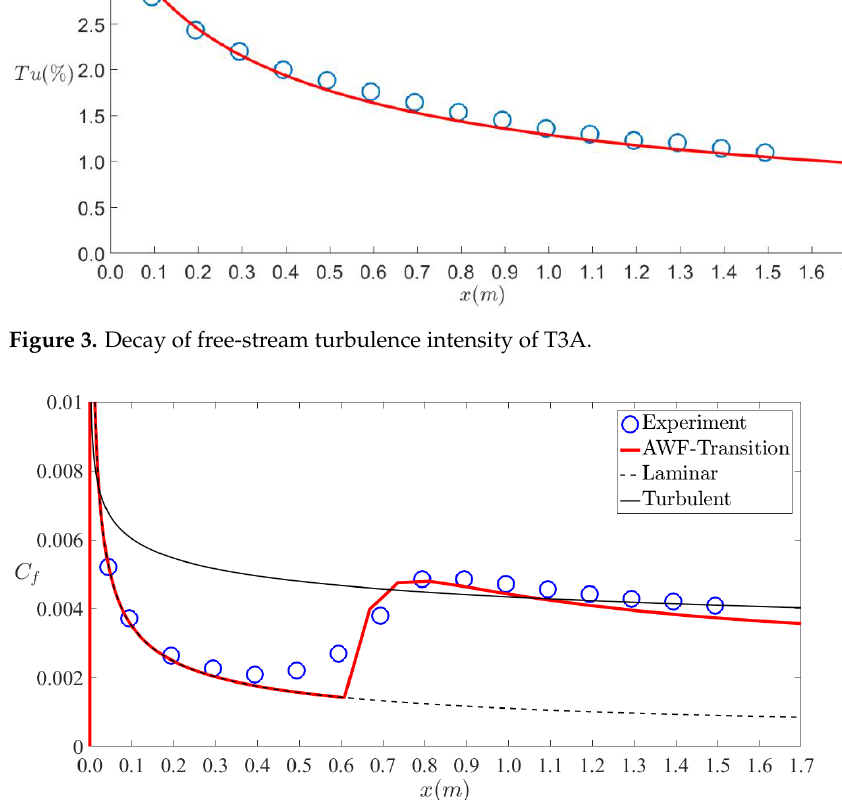
Figure 4. Skin friction coefficient distribution along a flat plate of T3A.